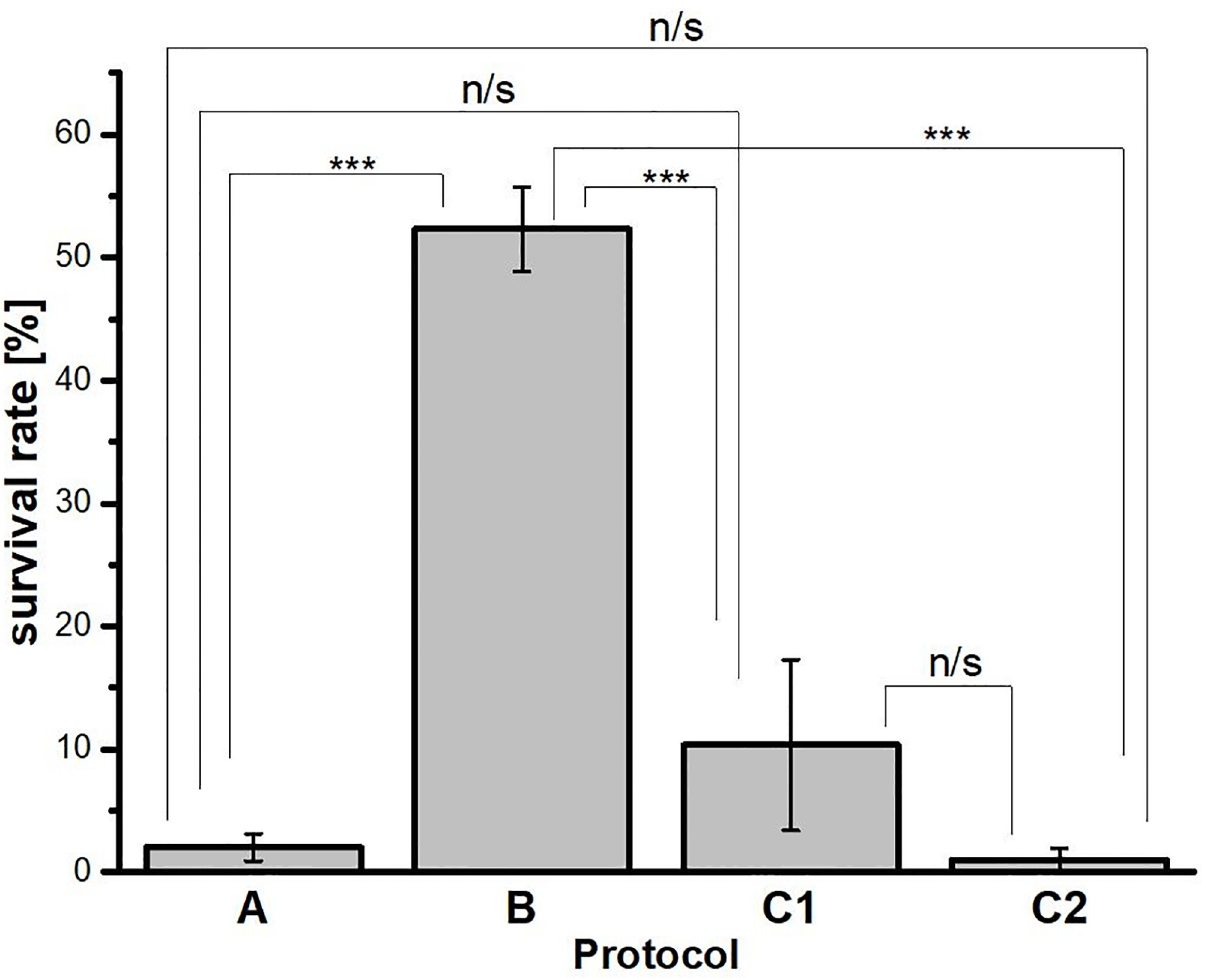
Fig 2. Survival rate of Hys . exemplaris specimens after 7 days in tun stage. The survival rate corresponds to percentage of specimens able to return to full activity after 24 h following rehydration. A, B, C1 and C2—symbols assigned to applied anhydrobiosis protocols. A, preconditioning on agar; B, slow dehydration on filter paper; C1, environmental drying in moist fine sand; C2, environmental drying in pond sediment. Data represent mean values ± SEM (see also Table 1). ��� p < 0.001; n/s, not statistically